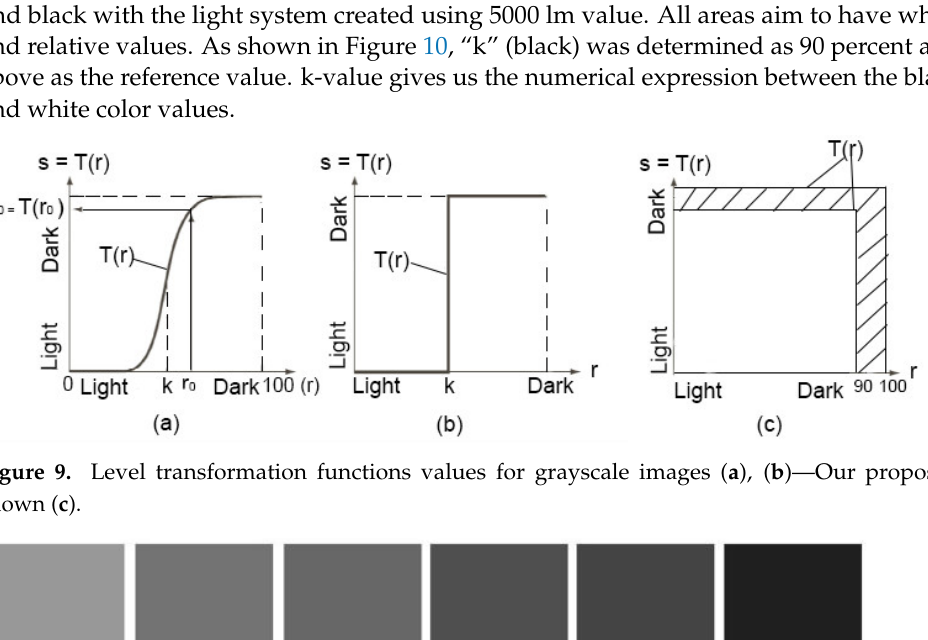
Figure 8. 3 × 3 neighborhood about a point in an image.